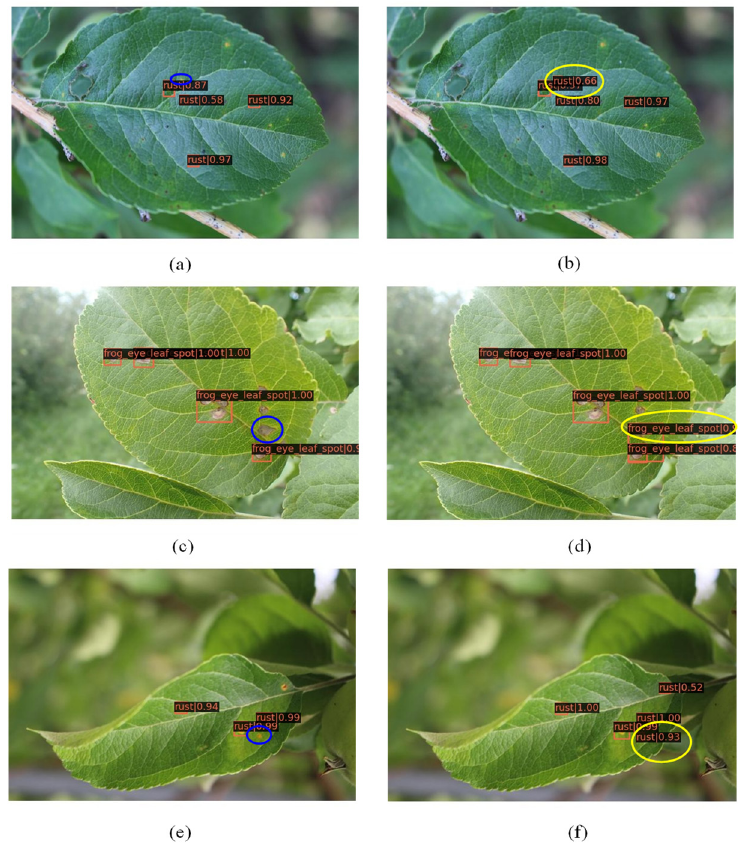
Figure 7. Comparison of NMS and soft-NMS test results. The left column ( a , c , e ) shows that Faster R-CNN with NMS produces some missed diseases under dense conditions. The right column ( b , d , f ) exhibits that Faster R-CNN overcomes the influence of the connected diseases by a linear penalty function. (The orange box represents the predicted bounding box; blue circle is the object missed to recognize in Faster R-CNN with NMS and yellow circle denotes the detection objects in Faster R-CNN with